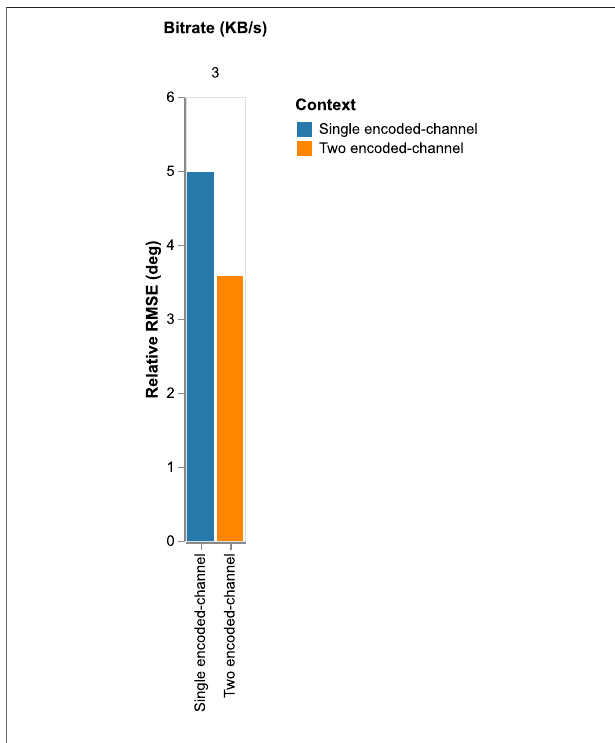
FIGURE 16 | Relative RMSE degradation for a varying bitrate performed for the two models: 1) Single encoded-channel model where one of the channels iswithout compression and the second isencoded withLyra. 2) The two encoded-channelmodel where the twoinputs are encoded similarly with Lyra at a varying bitrate.